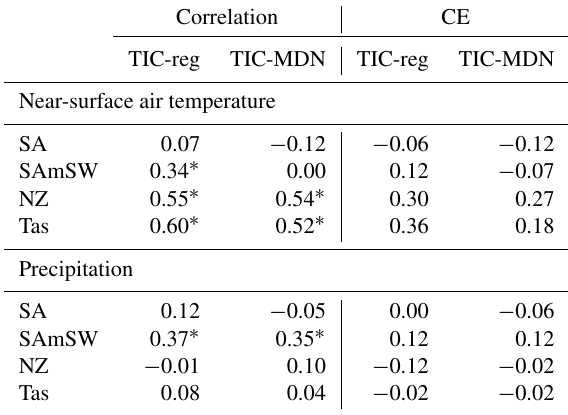
Table 3. Pearson correlation coefficient and coefficient of efficiency (CE) between the reconstructed and GMF near-surface air temper- ature and precipitation over 1901–2000CE for different DA exper- iments with both ice core and tree-ring proxies (Table 1) and for different regions (Sect. 3). SA stands for South America, SAmSW for the southwestern border of South America in the Andes where the TRW proxy sites are located, NZ for New Zealand and Tas for Tasmania. Asterisks stand for significant correlation coefficients at the 95% confidence level.